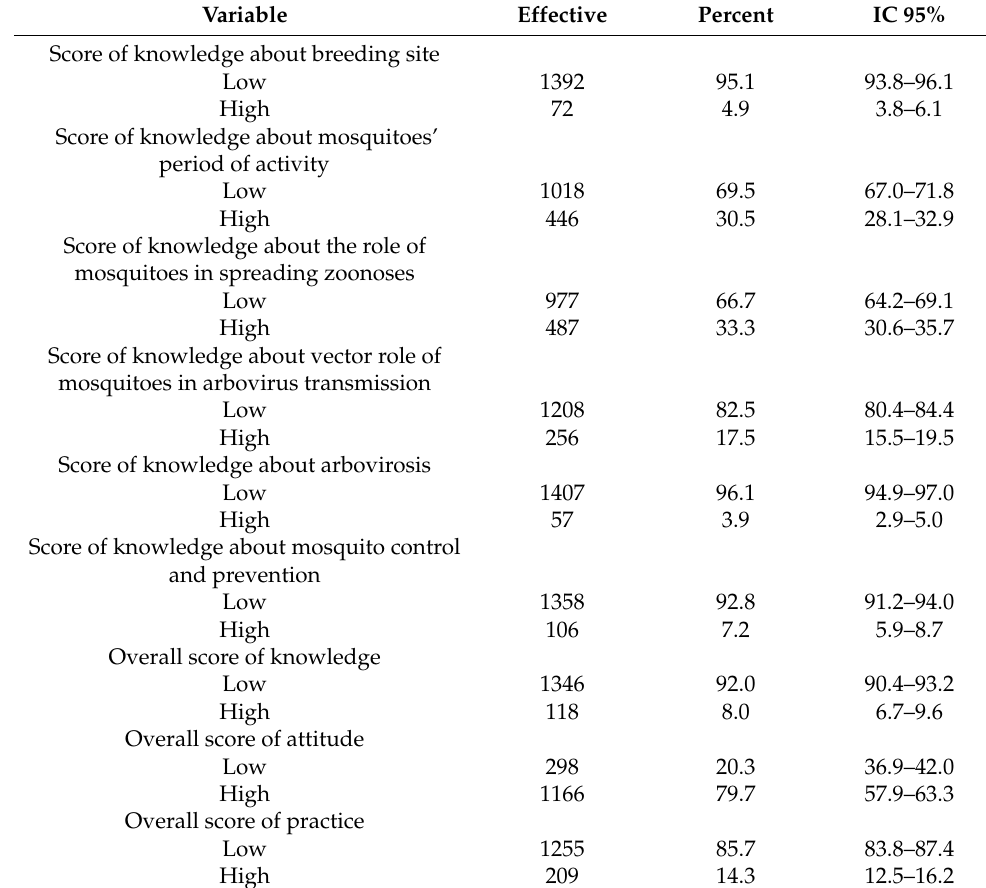
Table 5. KAP score about mosquitoes and mosquito-borne viral diseases (MBVDs) in Kinshasa, 2019.